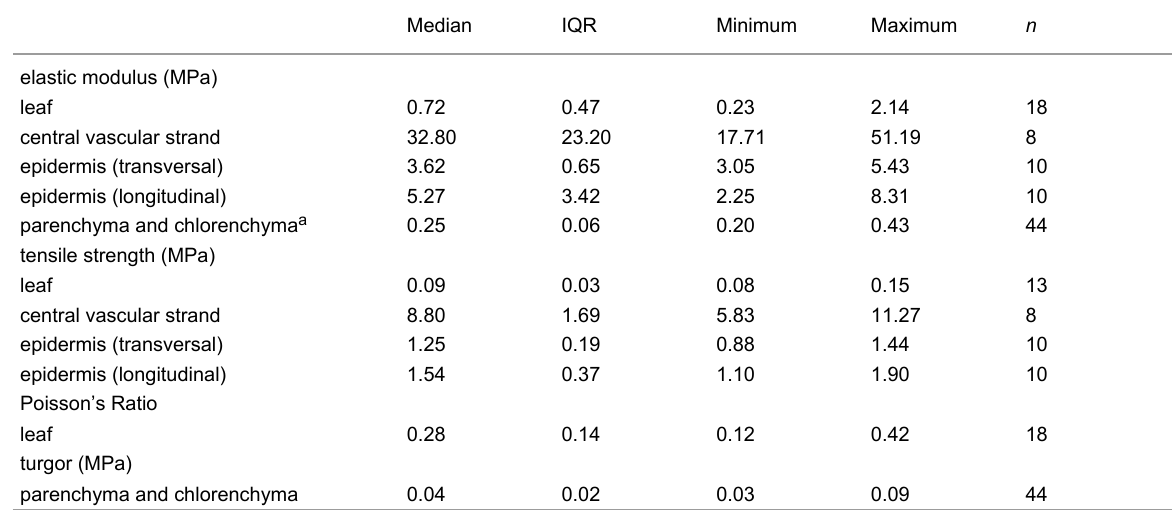
Table 2: Mechanical properties and additional mechanically important characterization of adult leaves of Delosperma cooperi. IQR stands for interquartile range.